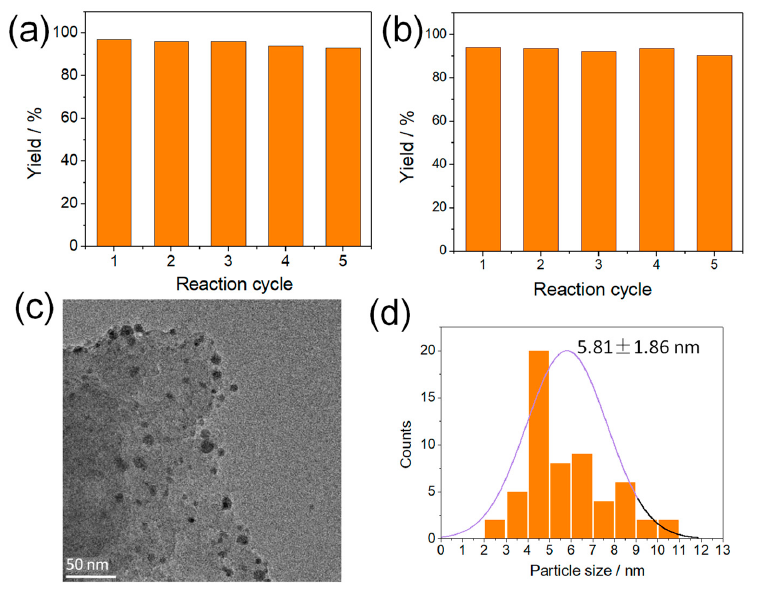
Figure 7. Recycling performance of Ag@NPOP-1 displaying: ( a ) carboxylative cyclization of propar- gylic amines, ( b ) carboxylation of phenylacetylene with CO 2 , ( c ) HR-TEM image, and ( d ) Ag particle size distribution of Ag@NPOP-1 after reuse for five cycles.